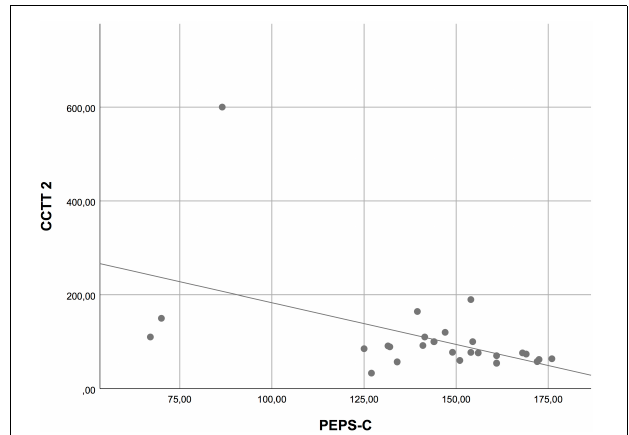
FIGURE 2 | Scatter plot displaying the correlation between PEPS-C and CCTT-2.